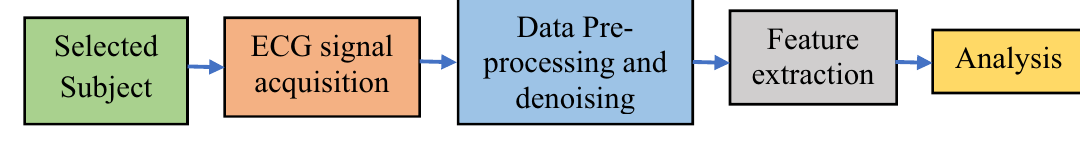
Figure 1. General procedures of the